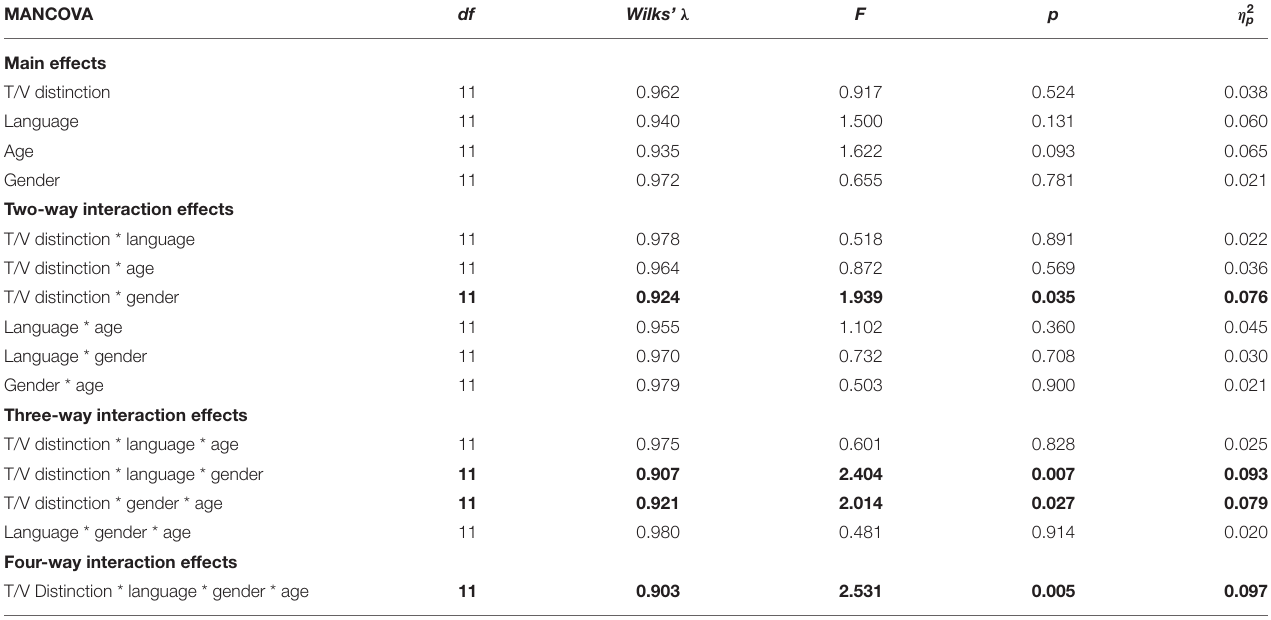
TABLE 3 | MANCOVA model results. MANCOVA